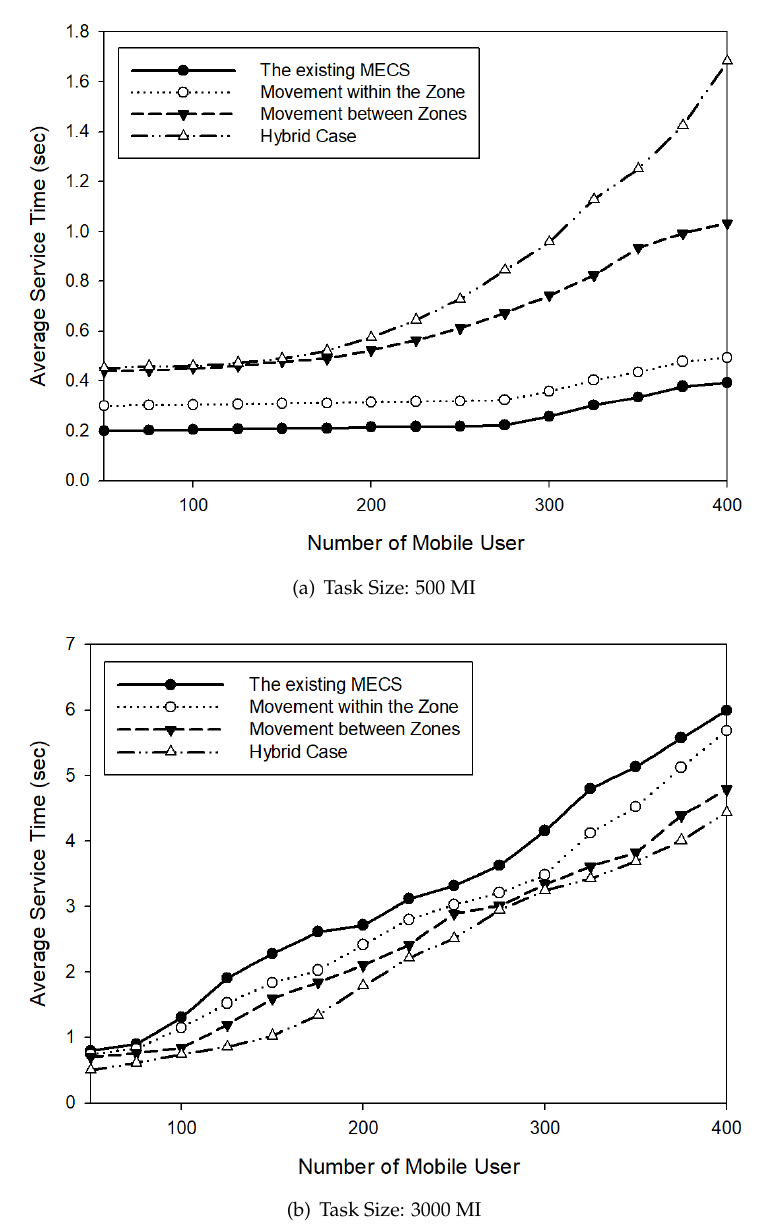
Figure 9. Average service time for various task sizes: ( a ) 500 MI task size; and ( b ) 3000 MI task